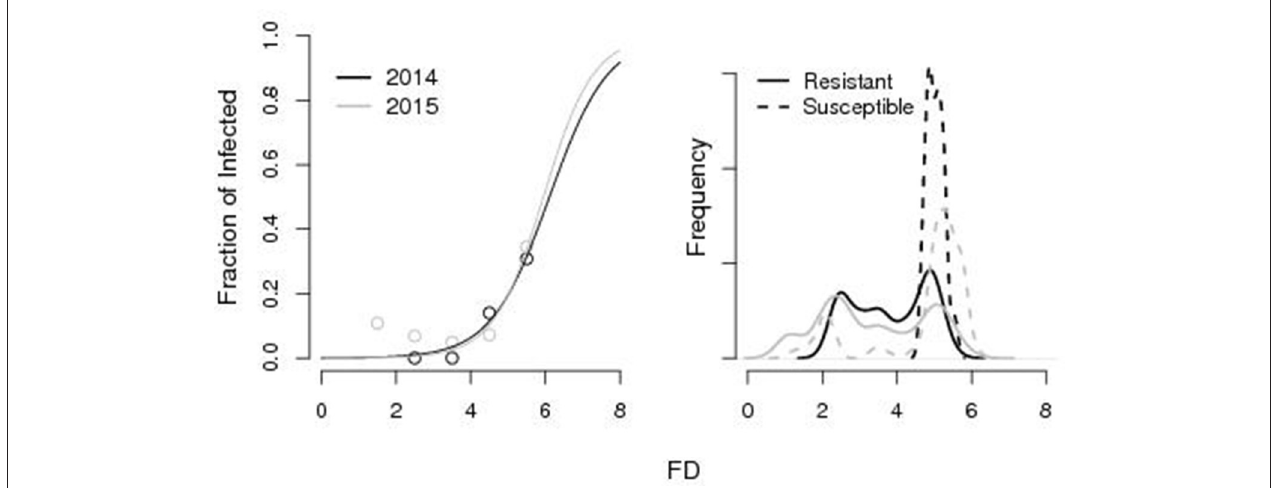
FIGURE 2 | Results from laboratory infections. Left : Fraction of susceptible fruits as a function of the fruit diameter (FD). Right : Frequency density distribution of resistant and susceptible fruits as a function of the FD (cm). The pattern is well described by the logistic function h 1 + e a ( b − FD ) i for the 2014 and a = − 1.5, b = 5.95 for the 2015.